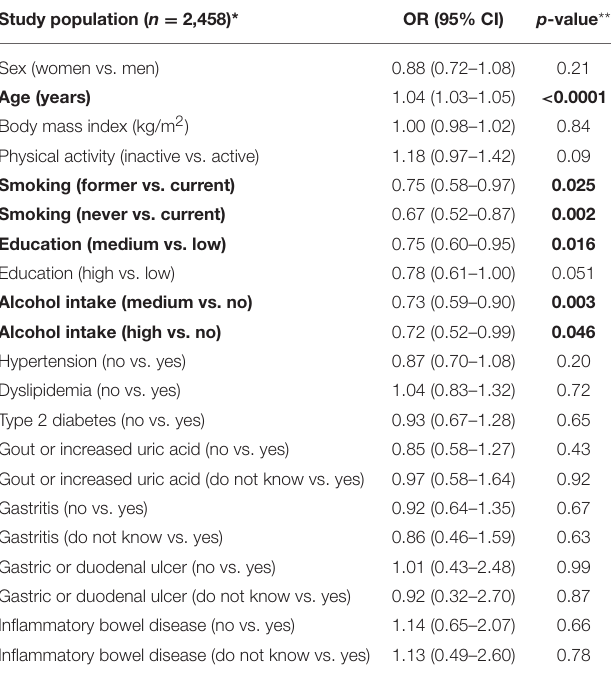
TABLE 2 | Variables associated with H. pylori seropositivity at the F4 survey. Study population ( n =